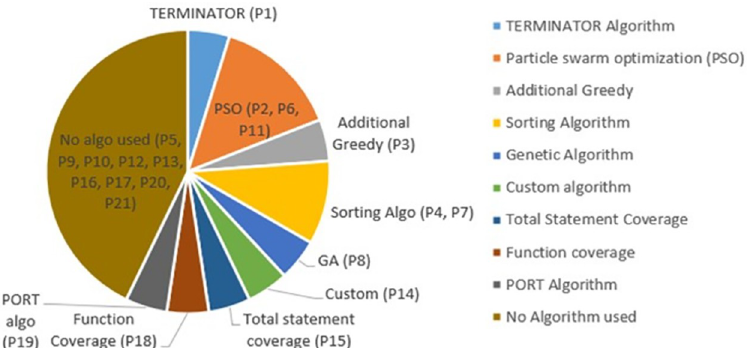
Fig 4. Distribution of studies according to the algorithm used.